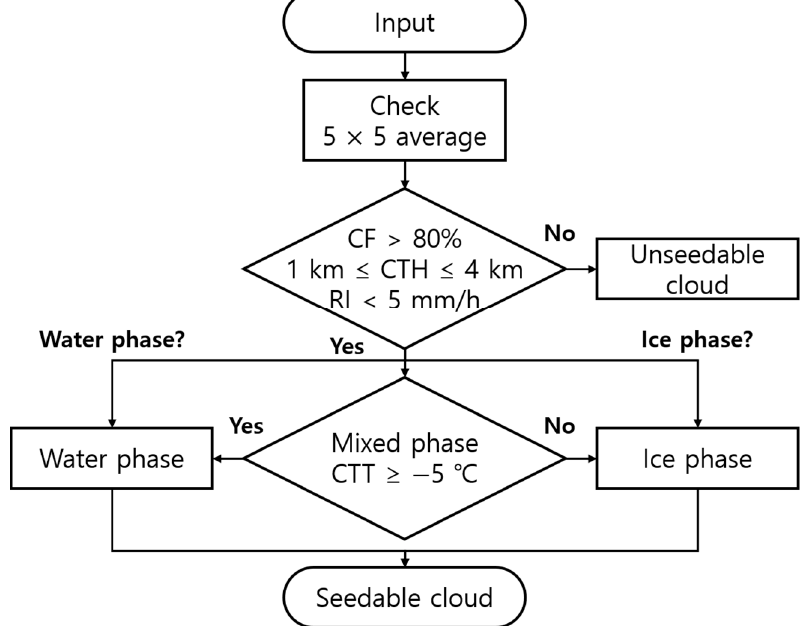
Figure 1. Flow chart of seedable cloud detection algorithm using COMS data (CF is cloud fraction, CTH is cloud top height, RI is rainfall intensity, CTT is cloud top temperature).